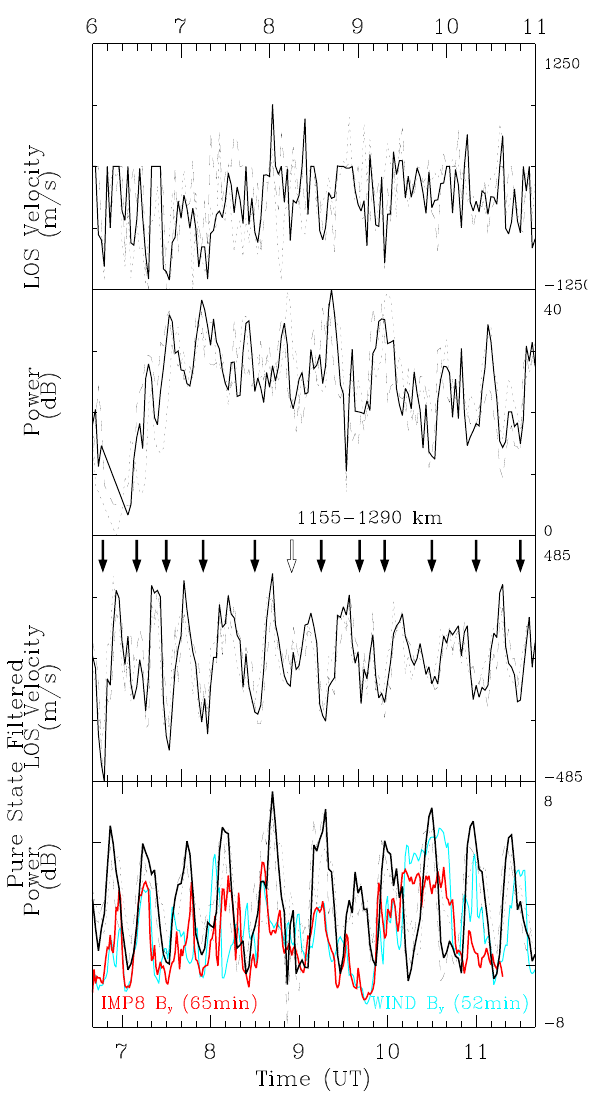
Fig. 7. Raw (top two panels) and pure-state-filtered time series ex- tracted from the LOS velocity and ground-scatter power data for radar beam 13. Time series for adjacent ranges are shown in dot- ted, solid and dashed lines. The arrows indicate large negative LOS velocities (PIFs). For convenience of comparison between filtered PIFs and TIDs, the filtered ground-scatter power (bottom panel) is plotted against the time axis that is appropriately shifted with re- spect to those in the upper panels. The IMF − B y observed by IMP 8 (red line) and WIND (blue line) are shifted by 65 and 52min,